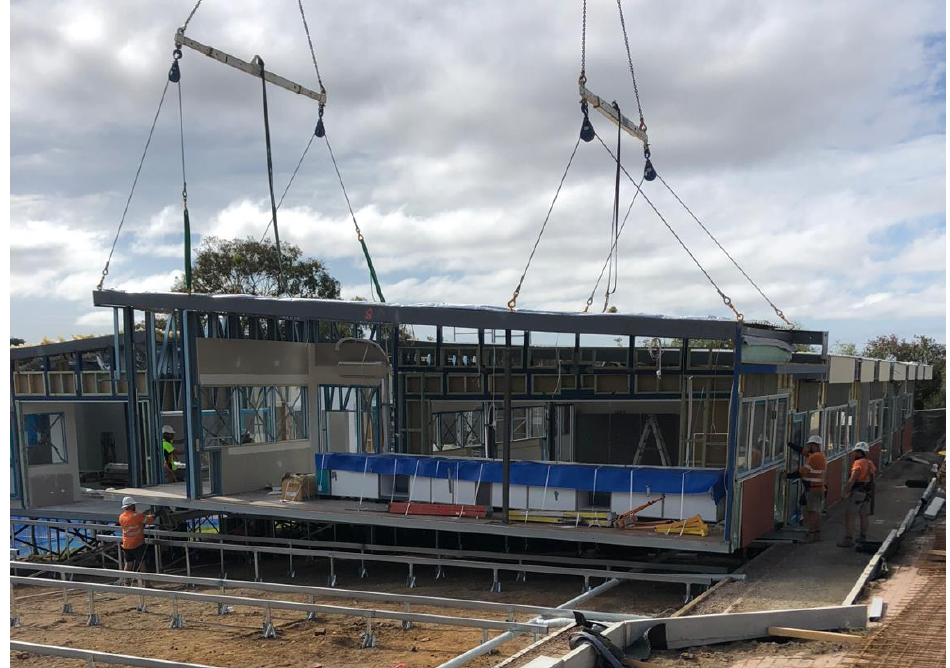
Figure 18. A partially finished modular unit being installed on top of a prefab foundation (driven in piles with a base plate and steel bearers on top).